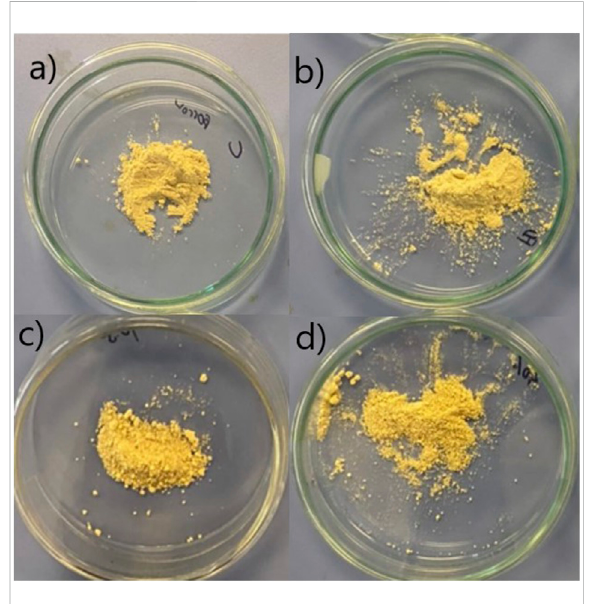
FIGURE 1 Chamomile extract powder obtained from convection oven- drying a), freeze-drying b), and spray-drying at 140 ° C, 10.5 ml/min c), and spray-drying at 140 ° C, 12 ml/min d).